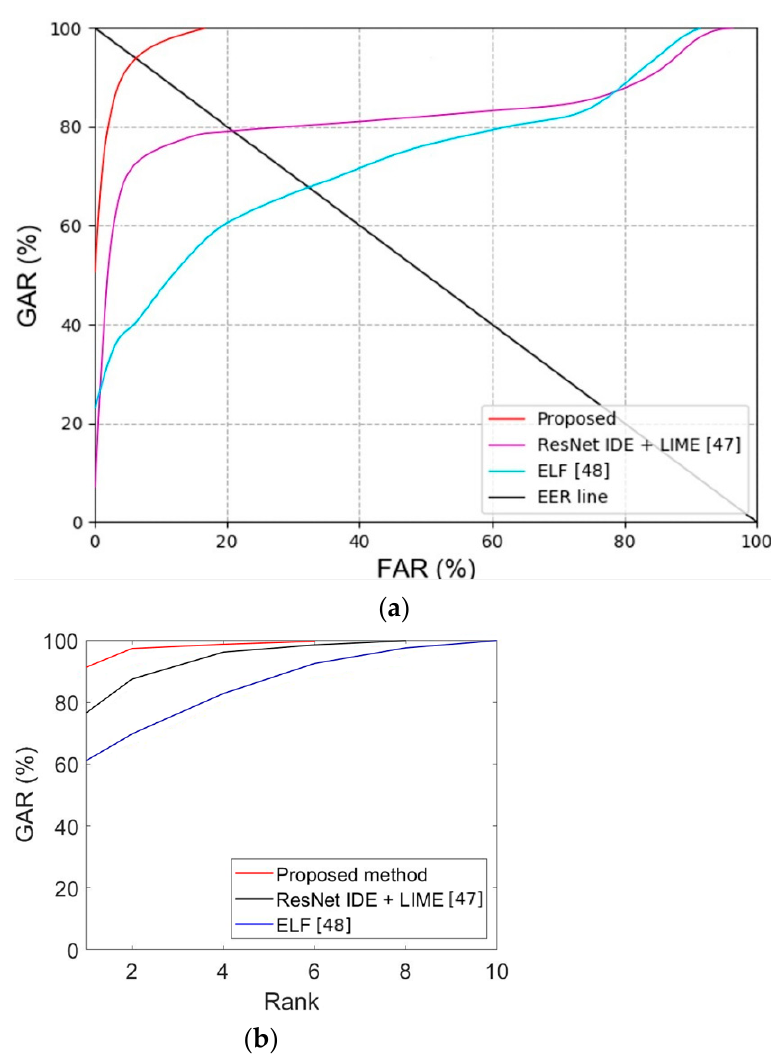
Figure 25. Comparisons of ( a ) ROC and ( b ) CMC curves obtained by the proposed method and state-of-the-art-methods with an open database.